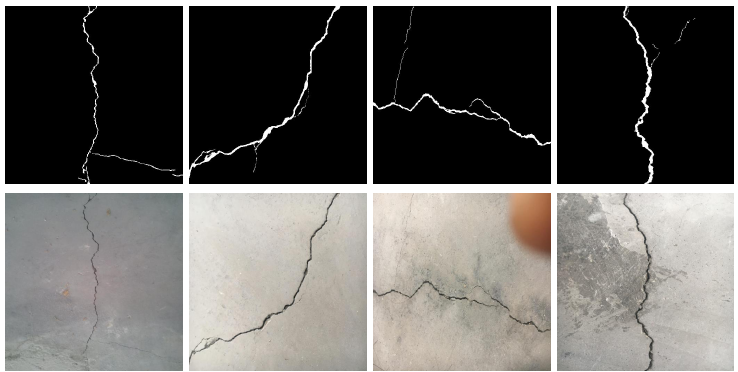
Figure 3. Samples of the dataset collected by [32]—First Tow: Ground truth of cracks; Second Row: Corresponding RGB